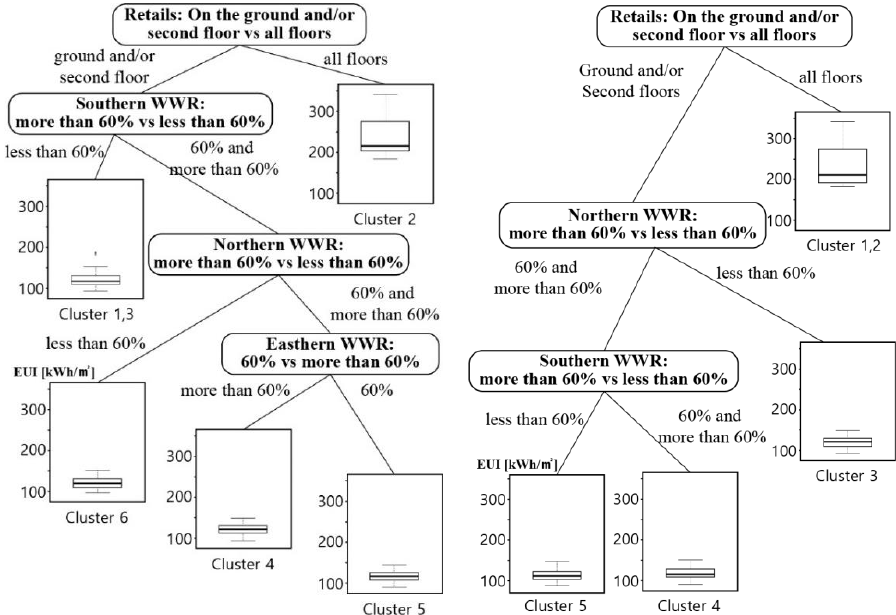
Figure 2. Decision support models by k-means ( left ) and SOM ( right